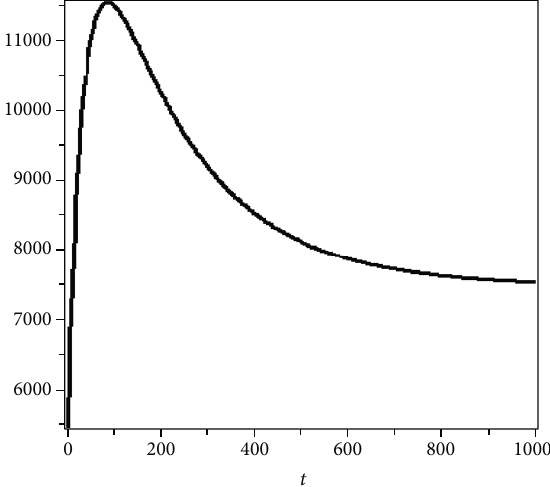
Figure 3: Global stability of endemic equilibrium E initial values.